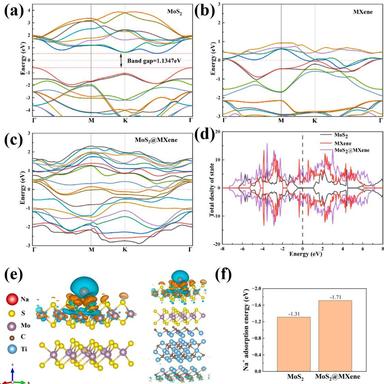
(a-c) energy band structure of MoS2, MXene, and MoS2@MXene, (d) total state density diagram of MoS2, MXene and MoS2@MXene, (e) charge density differences of the Na+ adsorbed on MoS2 and MoS2@MXene, (f) calculated adsorption energy of Na+ adsorbed on the surfaces of MoS2 and MoS2@MXene models.